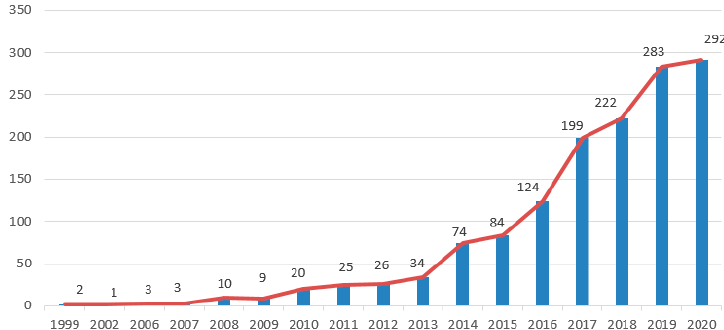
Figure 7. Increasing trend of literature about urban flood resilience.